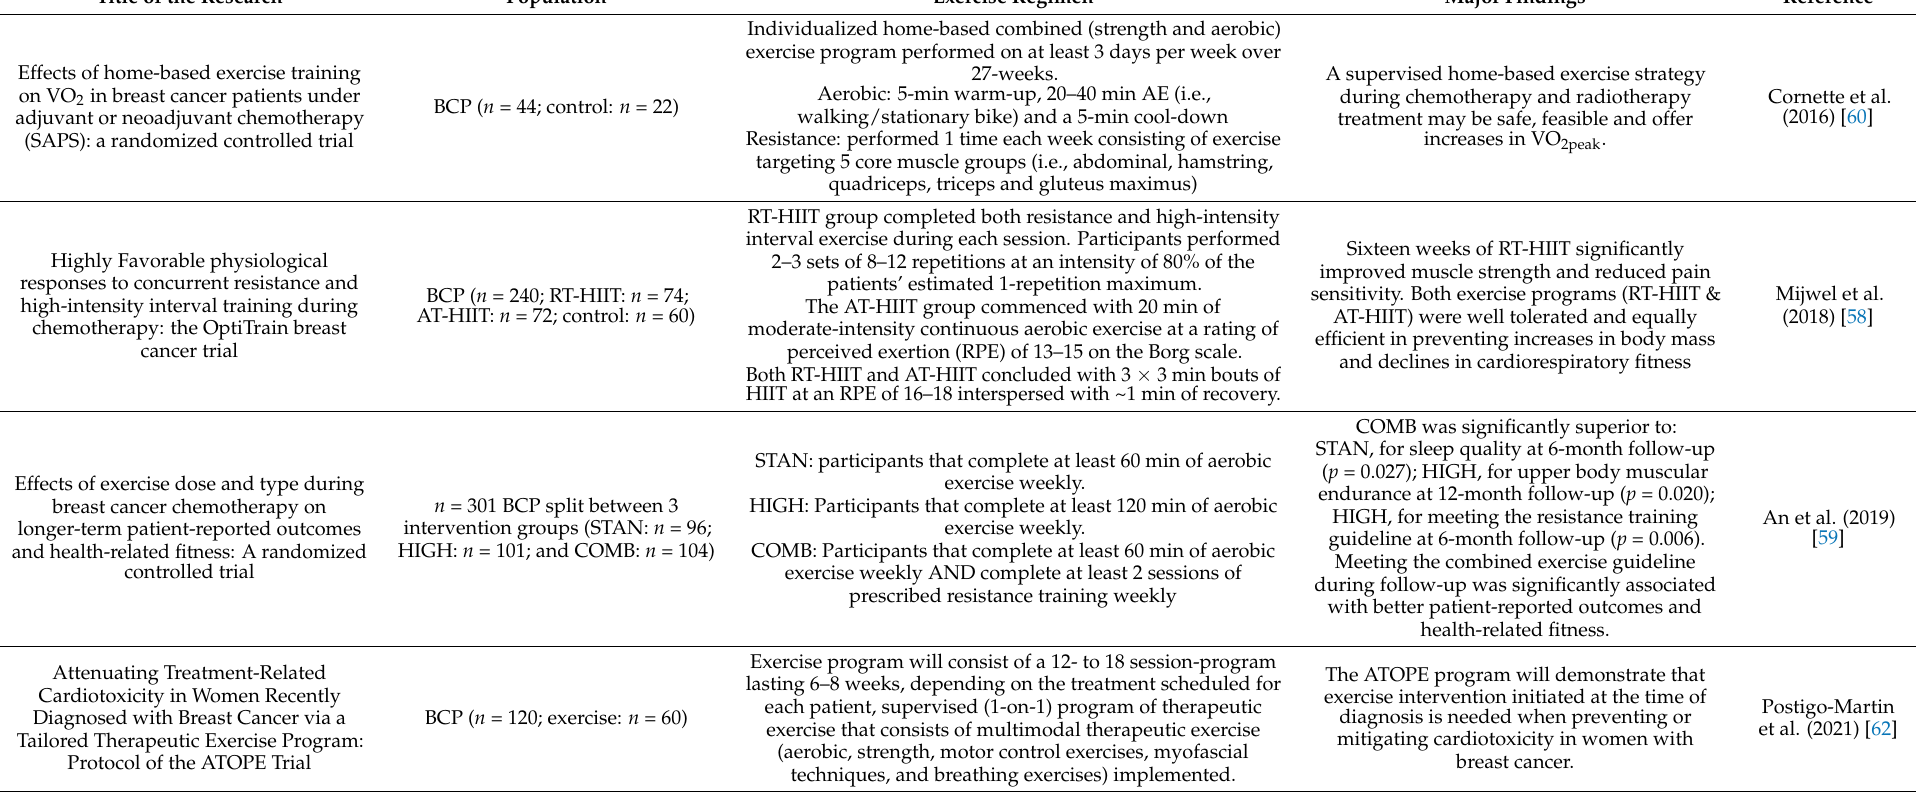
Table 4. Combination exercise clinical trials in breast cancer